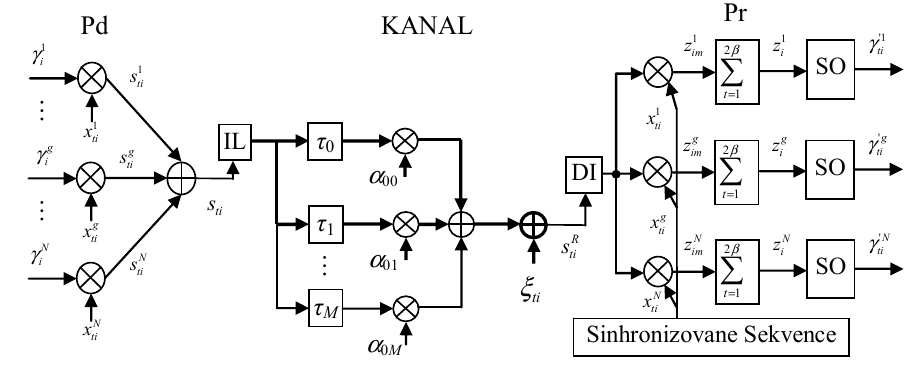
Figure 1 – Block-schematic of a CDMA system with chaotic code